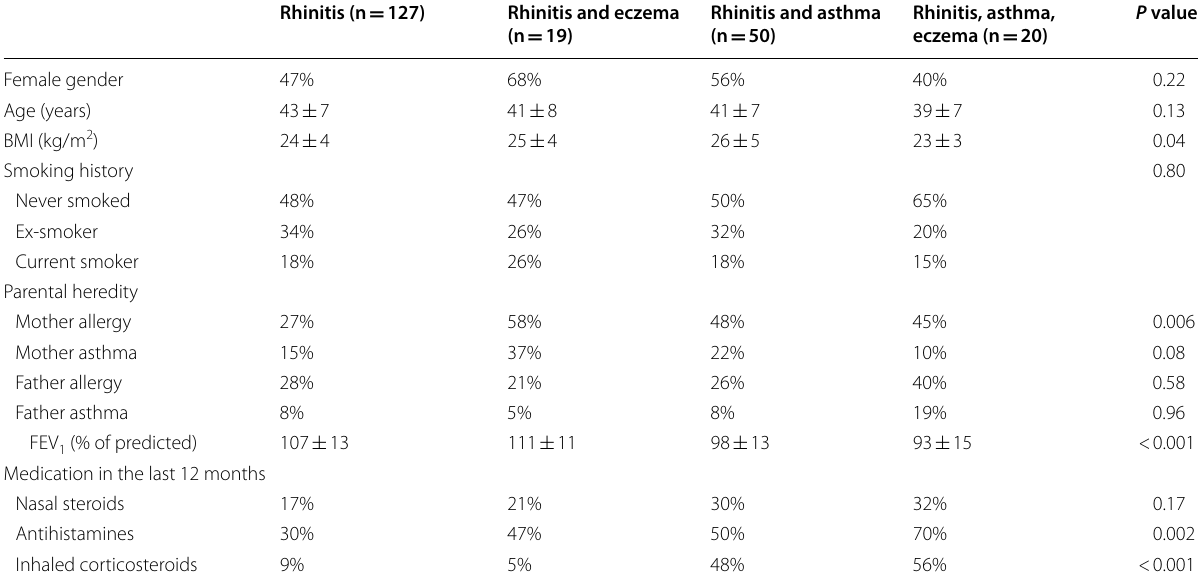
Data presented as % and mean SD ± Table 2 Inflammatory markers and total IgE in the participants (geometric mean (95% confidence interval)